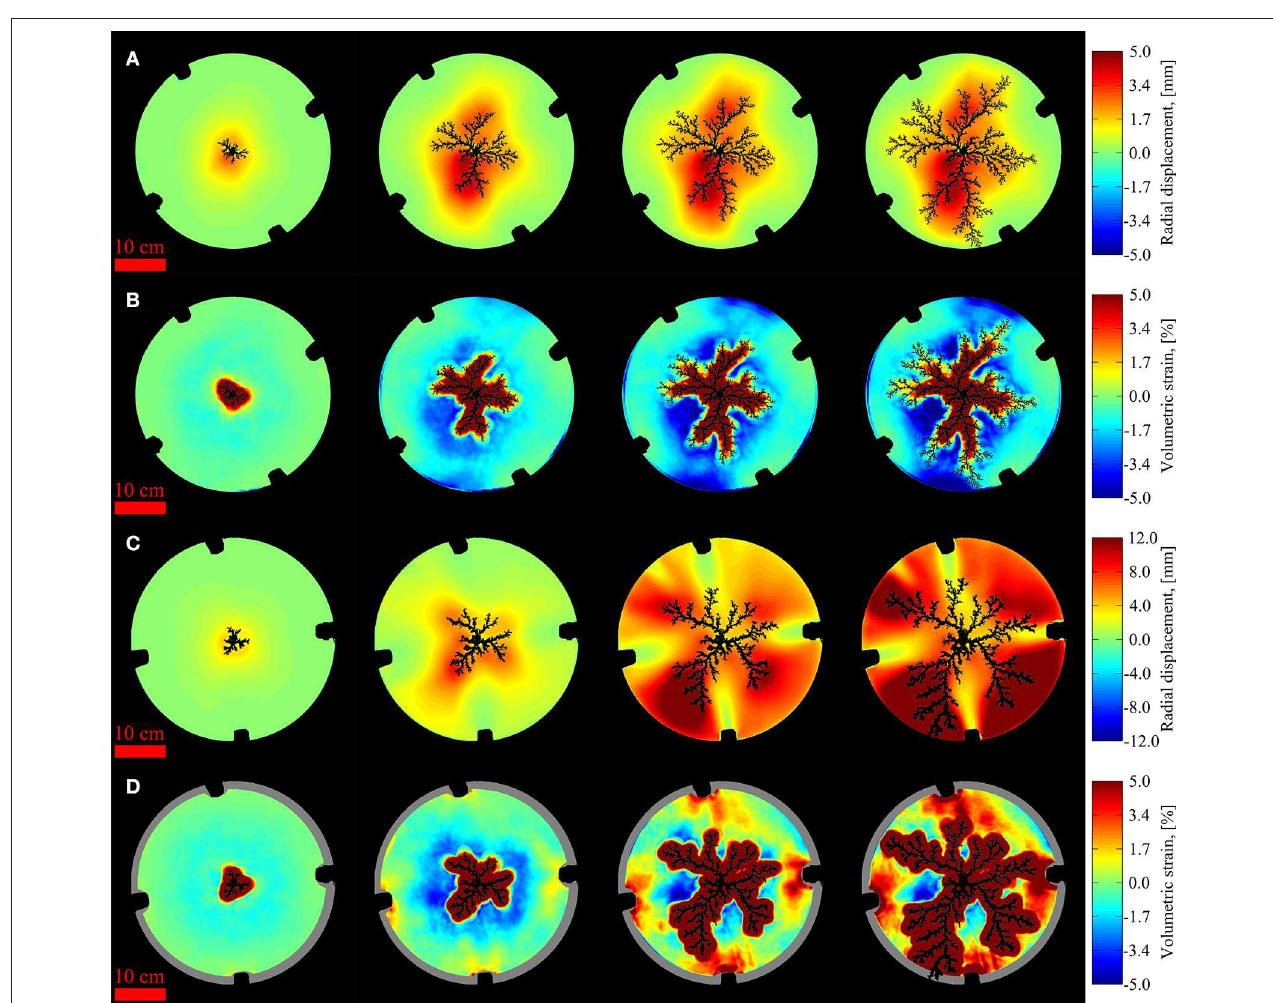
FIGURE 9 | Visualization of accumulated deformation at different snapshots during experiments: Radial displacements (A) and volumetric strains (B) in the confined deformable experiment with 100 hPa injection pressure. The radial displacements (C) and volumetric strains (D) are for the open deformable experiment with 100 hPa injection pressure. Time is increasing from left to right, where the snapshots in (A,B) are taken at 176, 488, 696, and 904 ms (i.e., 20, 54, 77, and 100% of the breakthrough time). The snapshots in (C,D) are taken at 232, 544, 960, and 1272 ms (i.e., 18, 43, 75, and 100% of the breakthrough time). For the radial displacements (A,C) , red color means that displacements are directed outwards and blue means inwards. For the volumetric strains (B,D) , red color means decompaction and blue means compaction. The air clusters and areas outside of the cell are shown in black, and the black bumps at the cell rim are due to the clamps. The gray areas in (D) indicate omitted data where boundary effects of beads leaving the cell influence the strain